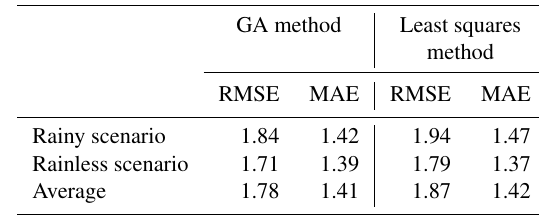
Table 3. Statistical results of the GA and the least squares method comparison; ECMWF data are shown as a reference (gm − 3